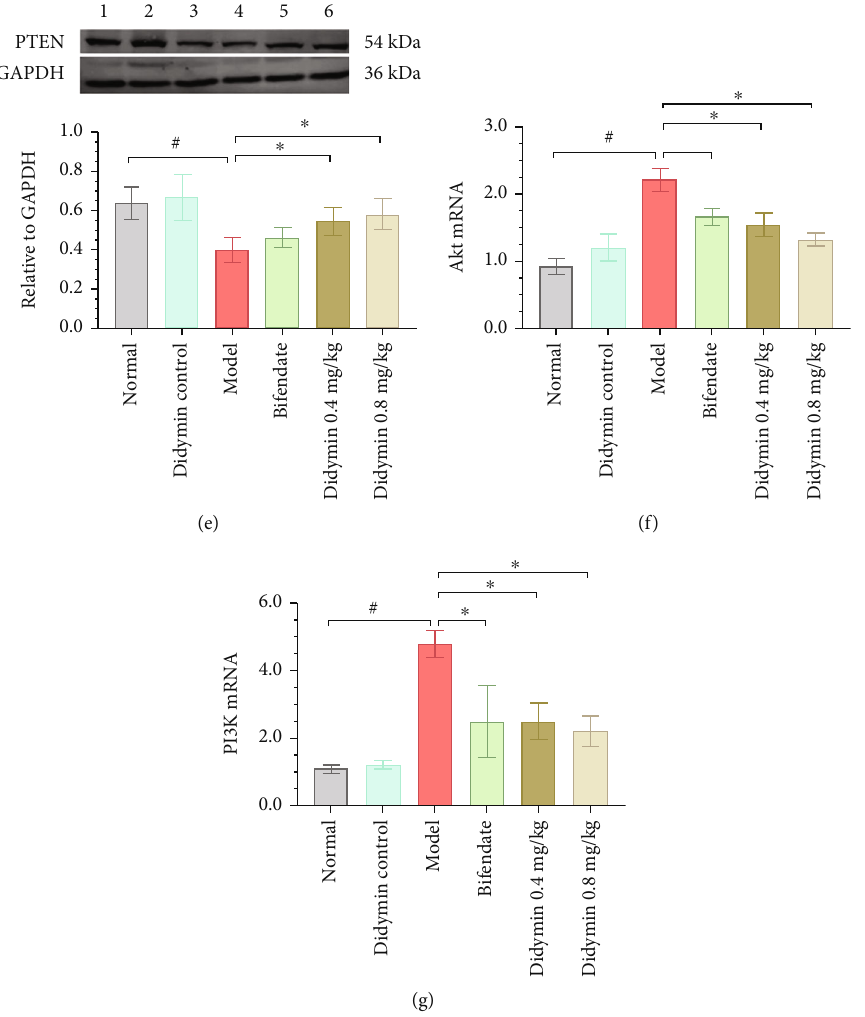
Figure 6: Didymin inhibited the PI3K/Akt pathway. (a – e) The expressions of p-PI3K, p-Akt, p-mTOR, P70S6K, and PTEN were determined by western blot. (f, g) The mRNA expression levels of PI3K and Akt were detected by RT-PCR assays. The bands 1 to 6, respectively, represent the normal control group, didymin control group, model group, bifendate-treated group, and low- and high- dosages of didymin-treated groups. The data are presented as mean ± SD . # P < 0 : 05 vs. the normal group; ∗ P < 0 : 05 vs. the model